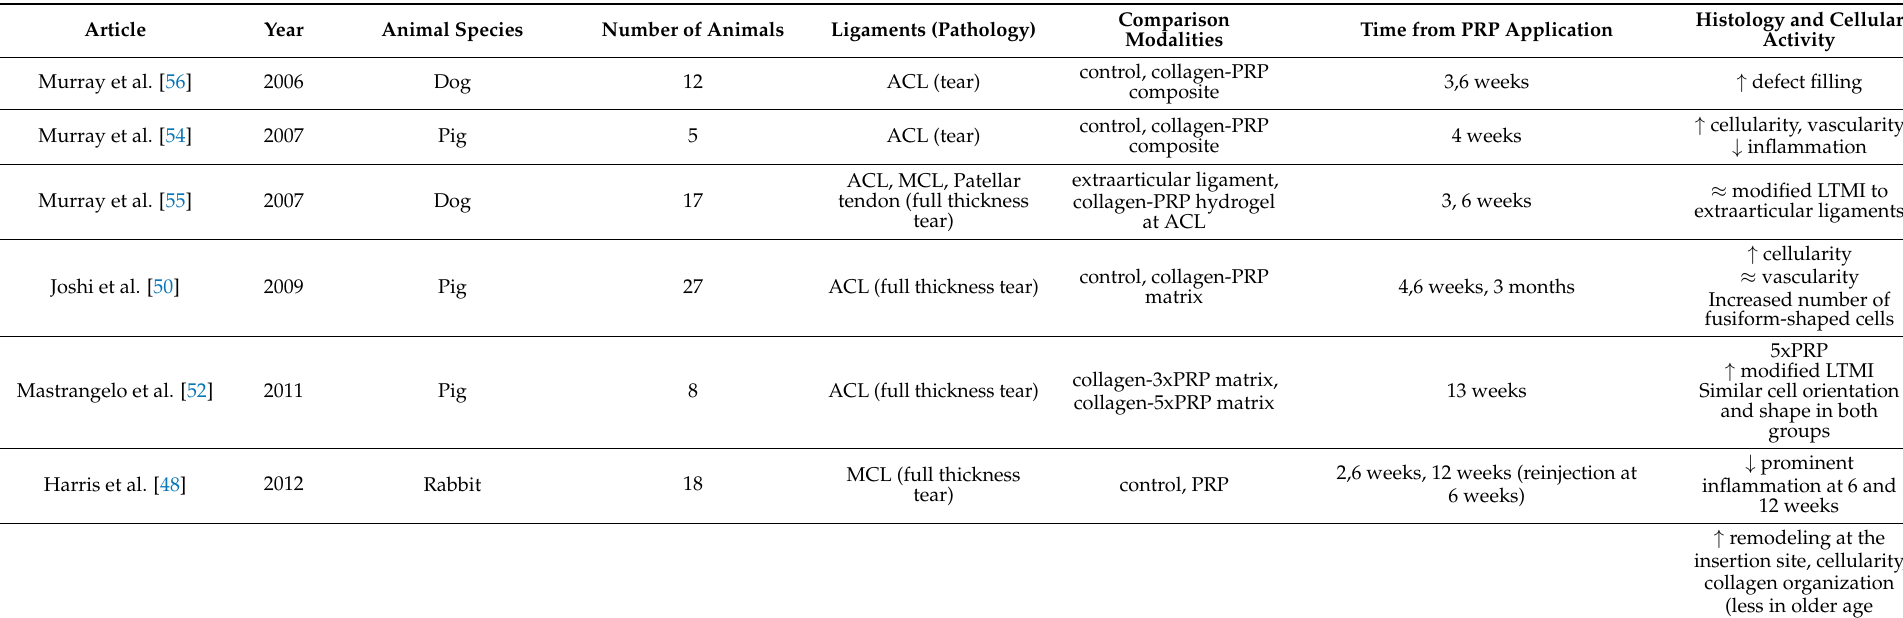
Table 2. Histological and molecular effect of PRP on ligaments in in vivo animal